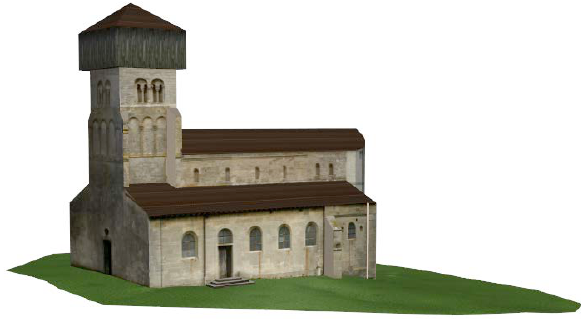
Figure 10. Final 3D model (3D pdf